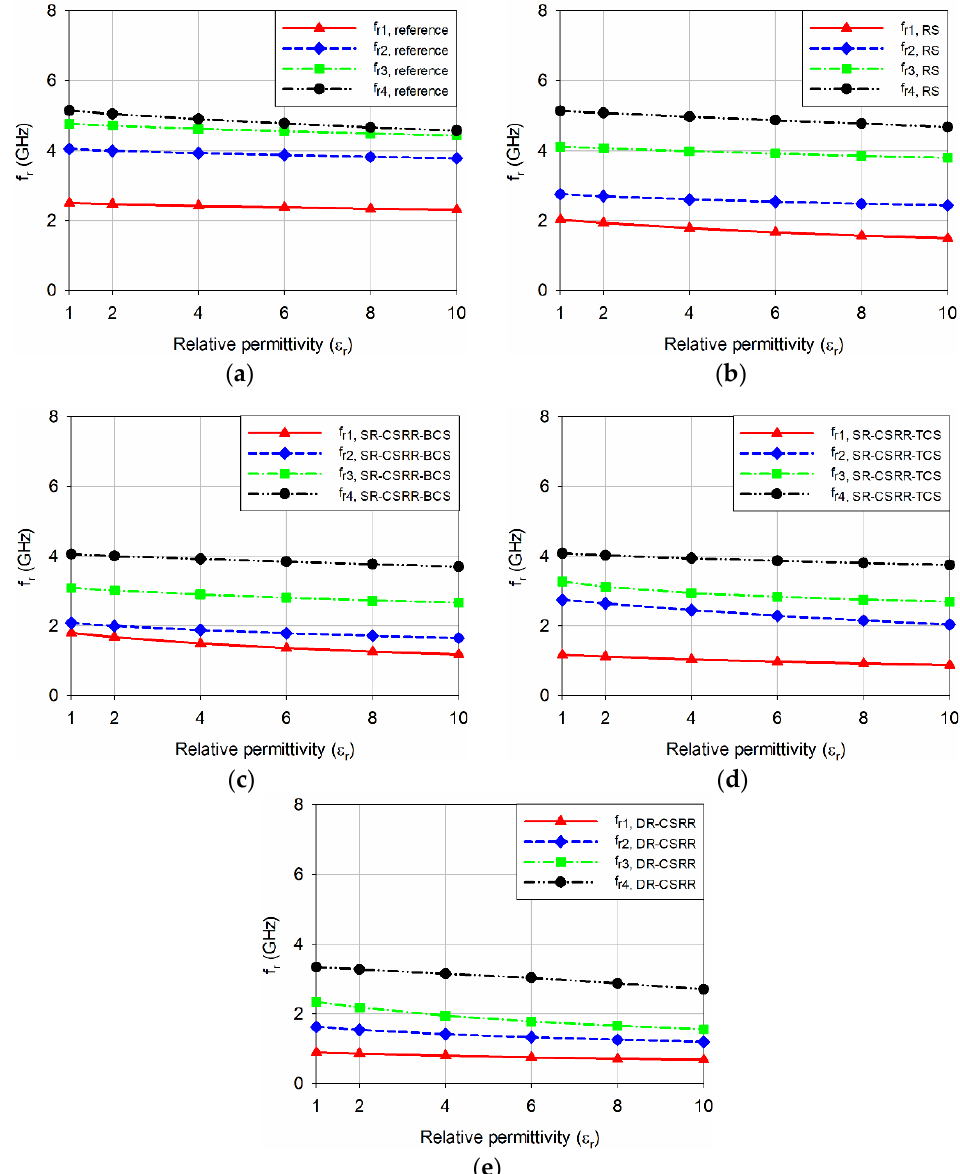
Figure 5. Input reflection coefficient responses of the reference and four slot ‐ loaded MPAs for var ‐ ying the relative permittivity of the MUT superstrate from 1 to 10: ( a ) the reference rectangular MPA, ( b ) the RS ‐ loaded MPA, ( c ) the SR ‐ CSRR ‐ BCS slot ‐ loaded MPA, ( d ) the SR ‐ CSRR ‐ TCS slot ‐ loaded MPA, and ( e ) the DR ‐ CSRR slot ‐ loaded MPA.